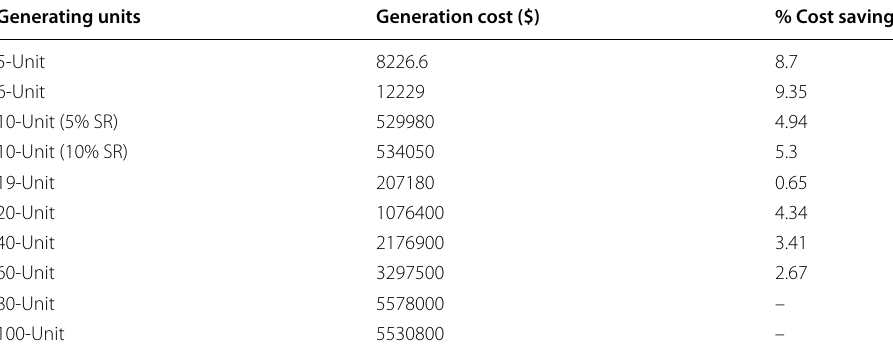
Table 24 Overall cost for generation of each unit with renewable energy sources in